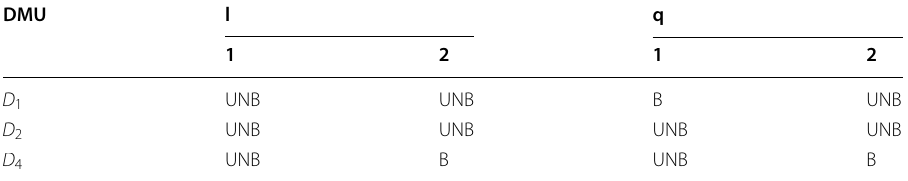
Table 3 Example 2: The results of evaluation BCC‑efficient DMUs by models (8) and